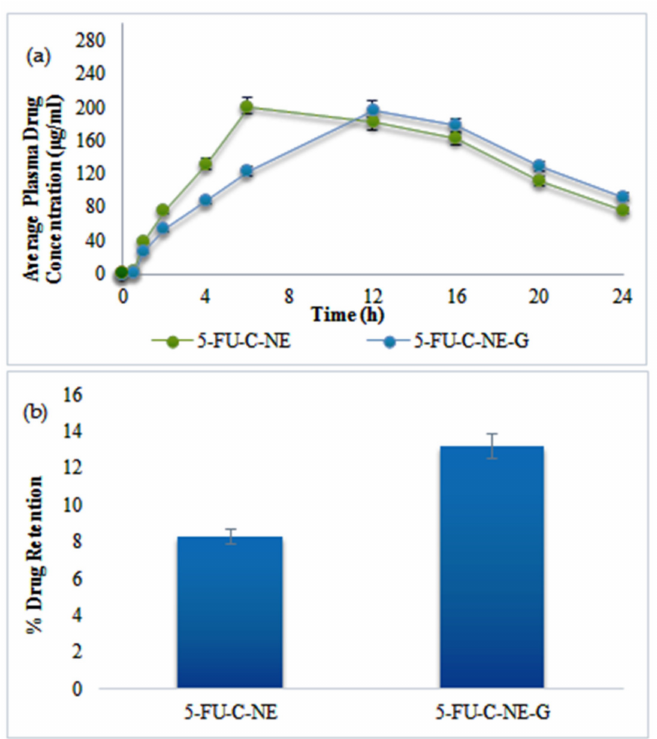
Figure 6. Average plasma drug concentration in µ g/mL ( a ) and skin drug retention ( b